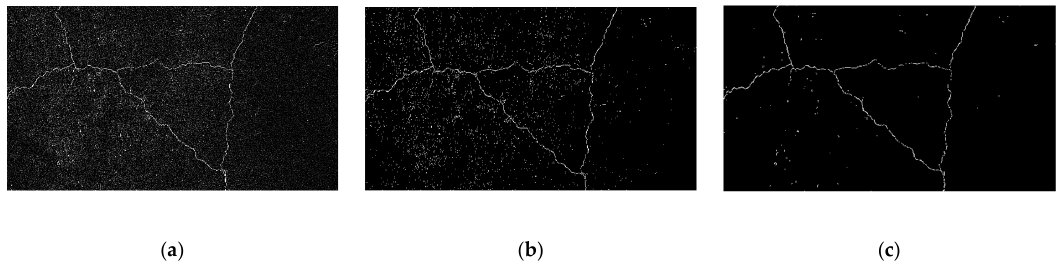
Figure 7. ( a ) Enhanced edge, ( b ) first-level binary, and ( c ) second-level binary images; defected dataset, Figure 7 . ( a ) Enhanced edge, ( b ) first-level binary, and ( c ) second-level binary images; defected spatial domain, and LoG filter. Figure 7 . ( a ) Enhanced edge, ( b ) first-level binary, and ( c ) second-level binary images; defected dataset, spatial domain, and LoG filter. Figure 7 . ( a ) Enhanced edge, ( b ) first-level binary, and ( c ) second-level binary images; defected dataset, spatial domain, and LoG filter. dataset, spatial domain, and LoG filter.